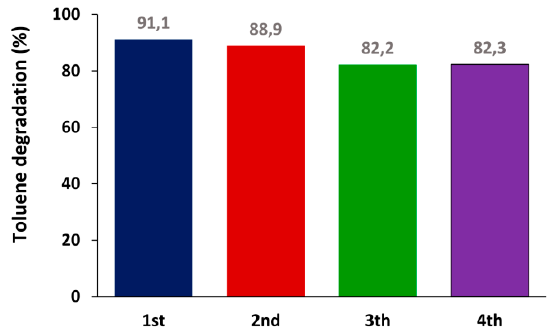
Figure 8. Photostability of TiO 2 / SnS_15% measured in the fourth subsequent cycles in the toluene degradation reaction in the presence of LED λ max = 375 nm.